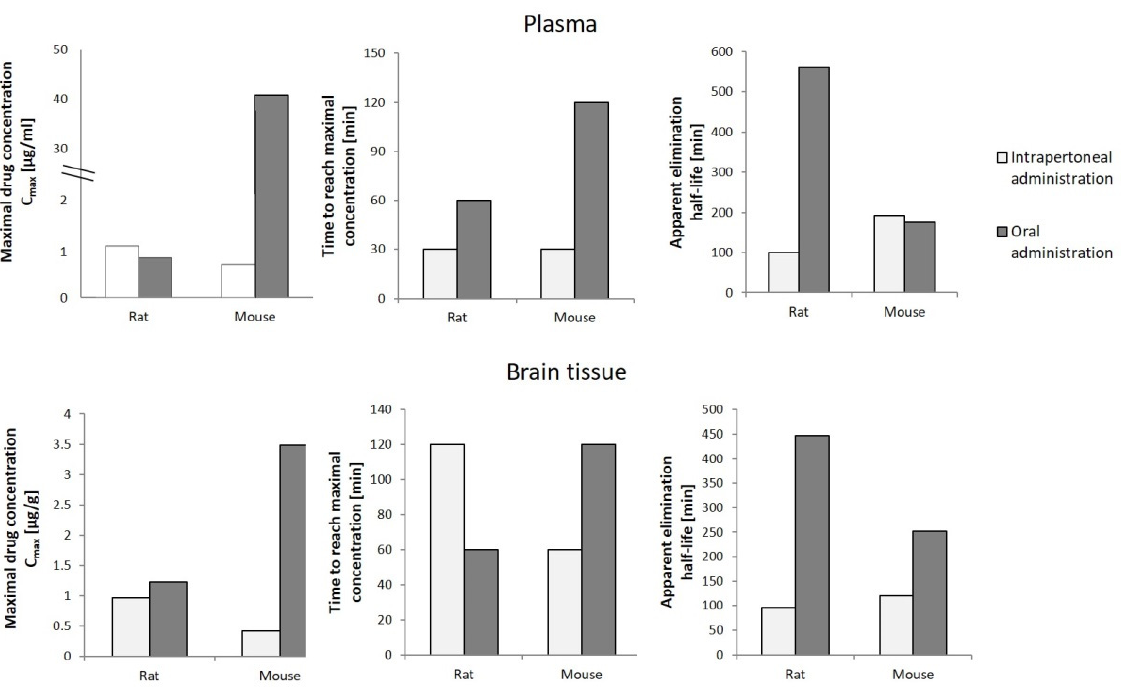
Figure 5. Pharmacokinetics of cannabigerol (120 mg/kg) in rats and mice depending on the mode of administration [72].